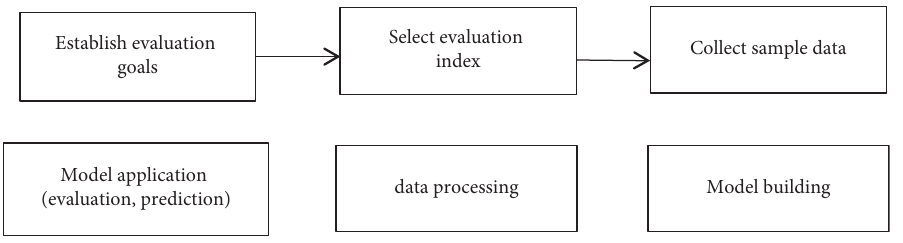
Figure 6: Building the idea.